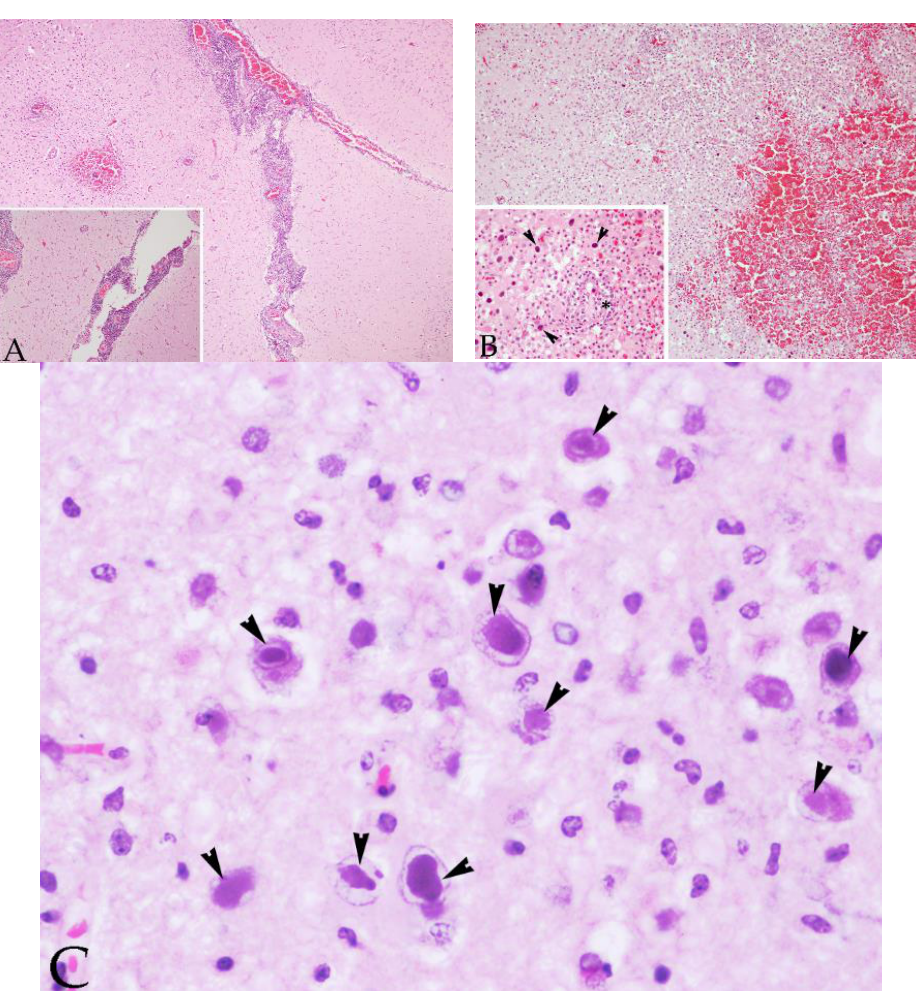
Figure 2. Histopathological brain lesions from case 5: ( A ) Brain cerebral cortex sample of case 5, a juvenile male striped dolphin presenting 7/7 of the evaluated brain lesions. Severe non-suppurative meningitis is present. Original magnification ×4; haematoxylin and eosin staining. Inset: Detail of perivascular cuffing and non-suppurative meningitis. Original magnification ×10; haematoxylin and eosin staining. ( B ) Brain cerebral cortex sample of case 5, a juvenile male striped dolphin pre- senting 7/7 of the evaluated brain lesions. Suffusive haemorrhages, malacia and perivascular cuffing are present. Original magnification ×10; haematoxylin and eosin staining. Inset: numerous ampho- philic intranuclear inclusion bodies were observed within the neurons and glial cells (arrowheads). Detail of perivascular cuffing (asterisk). Original magnification ×40; haematoxylin and eosin stain- ing. ( C ) Higher magnification of the basophilic intranuclear inclusion bodies (arrowheads). Original magnification ×60; haematoxylin and eosin staining. Two different sequences were obtained from case 6, an adult female striped dolphin. The sequence from the forward primer (153 nt sequence length) showed the highest nt similarity (93.46%) (100% QC) with α - HV sequences detected in the brain of a Risso’s dol- phin ( Grampus griseus ) stranded in 2013 in the Mediterranean Sea (GenBank Acc. No. KP995683) and with the sequence obtained from the intestine of a striped dolphin stranded in the middle of the second Mediterranean CeMV epizootic (GenBank Acc. No. GQ888671). The reverse sequence (159 nt sequence length) showed the highest nt identity